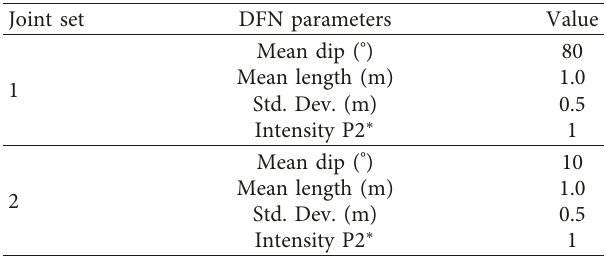
Table 6: Input parameters for the generation of the discrete fracture network (DFN)